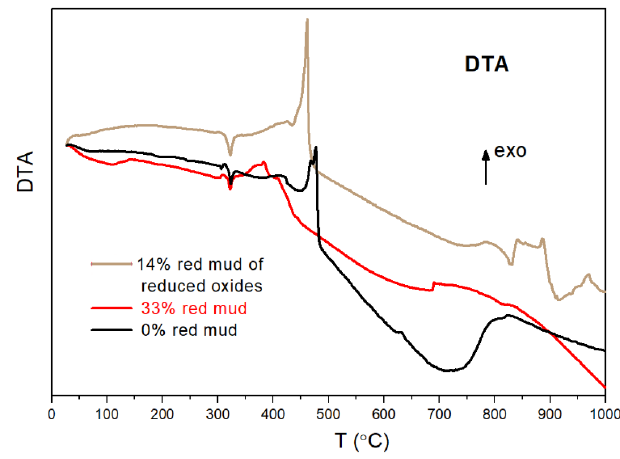
Figure 8. Differential thermal analysis of composites vs. red mud content.